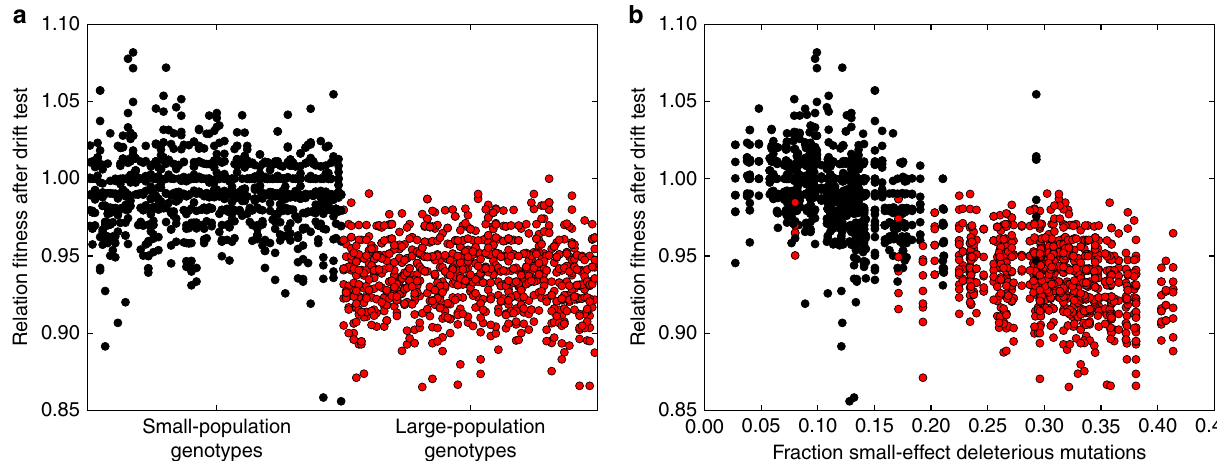
Fig. 5 Small-population genotypes are drift-robust due to a decreased likelihood of small-effect deleterious mutations. Black and red data points represent small-population genotypes and large-population genotypes, respectively. a Relative fi tness of the most-abundant genotype from every population during the drift robustness test. Each circle represents the relative fi tness of one genotype from one replicate. b Relationship between relative fi tness in the drift robustness test ( a ) and the likelihood of small-effect deleterious mutations (Fig.